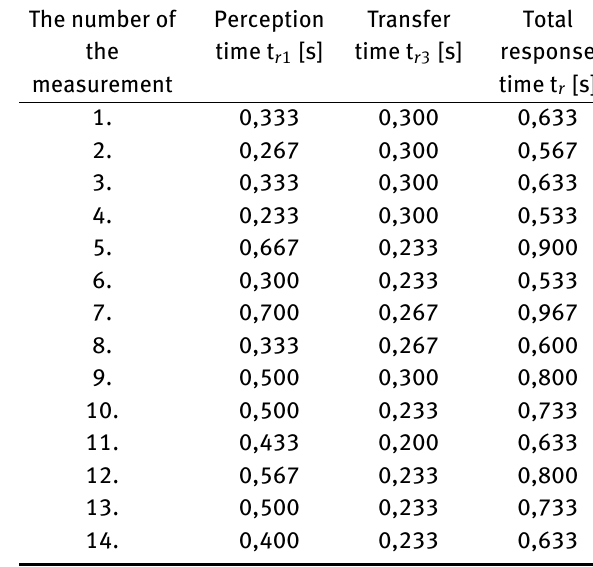
Table 17: Summary of the results of driver L. The number of the measurement